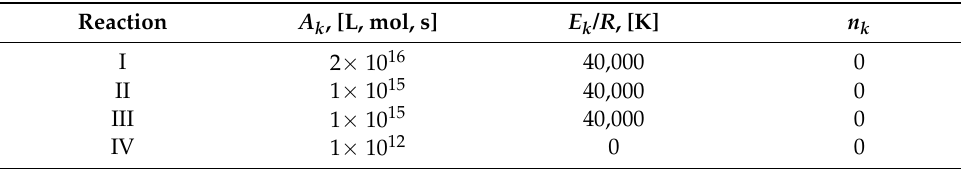
Table 1. Macrokinetic mechanism of soot